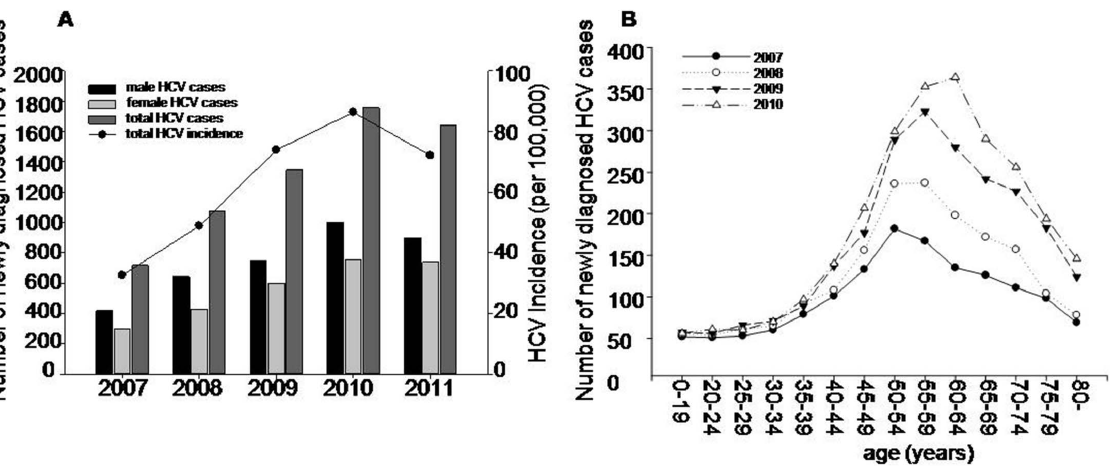
Figure 1. HCV infection was related to sex and age. A. Number of female, male, total cases and total newly diagnosed rate of newly diagnosed from 2007 to 2011 in Yanbian Prefecture, China. B. Number of HCV cases by age from 2007 to 2011.